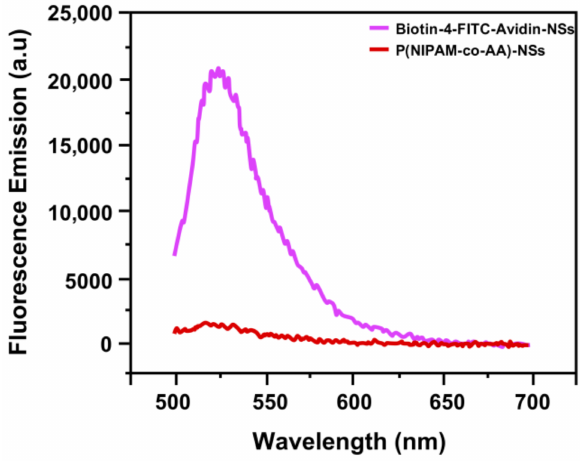
Figure 6. Fluorescence spectra of avidin-nanoparticles complexed with biotin-4-FITC (magenta) and the control experiment (hydrogel nanoshells,